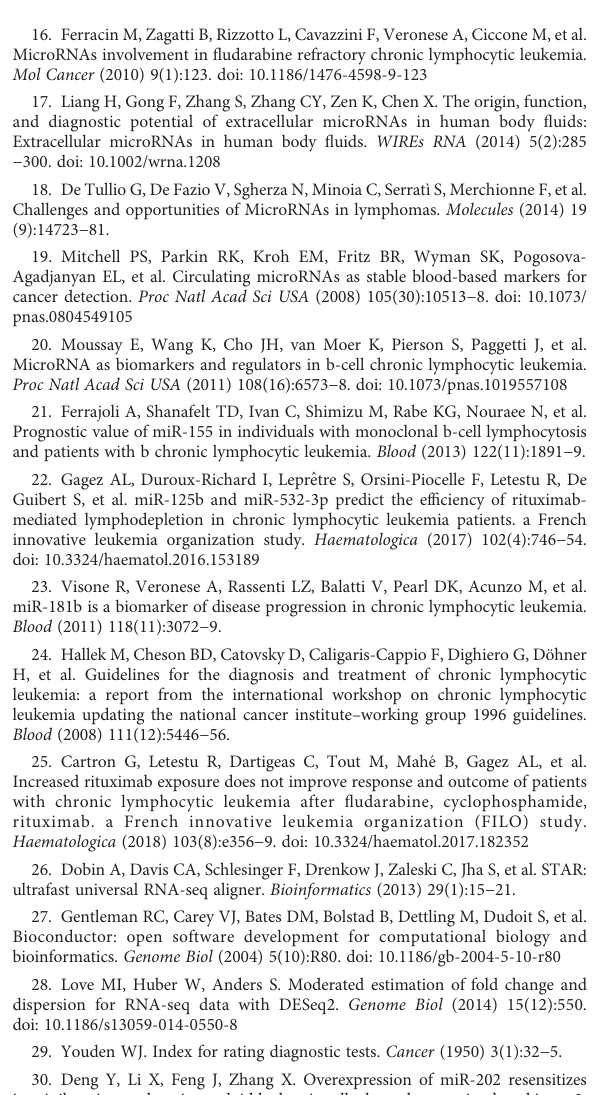
SUPPLEMENTARY TABLE 1 Association between patients ’ characteristics and achievement of CR, uMRD and CR with BM uMRD. CR, Complete remission; MRD, Minimum Residual Disease; uMRD, undetectable Minimum Residual Disease BM,